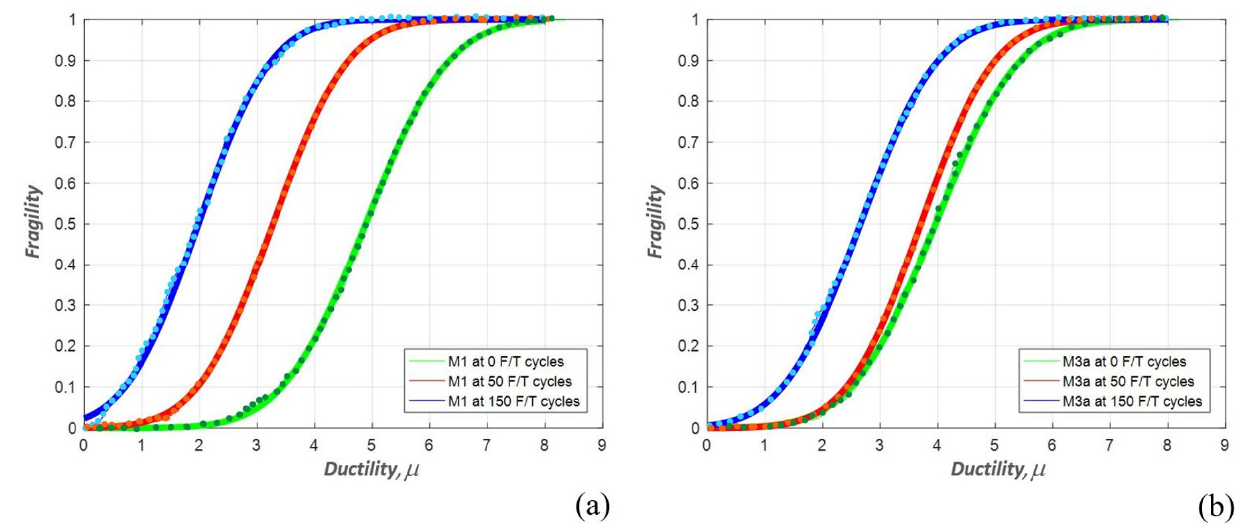
Figure 3. Fragility curves (assumption of normal probability distribution) for ductility for M1 ( a ) and M3a wallets ( b ). Note that bold lines correspond to theoretical cdfs, while dotted lines corresponds to the CAE estimation of cdfs.